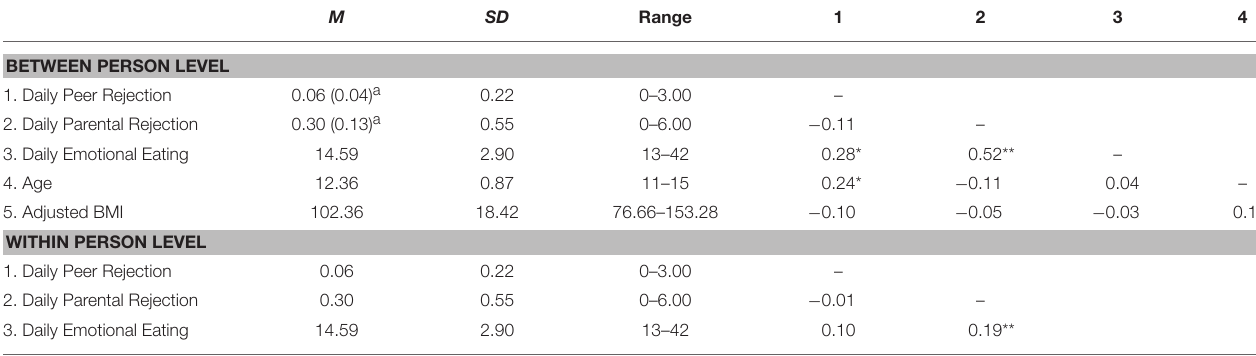
TABLE 1 | Descriptive statistics and correlations between dispositional and daily variables. M SD Range